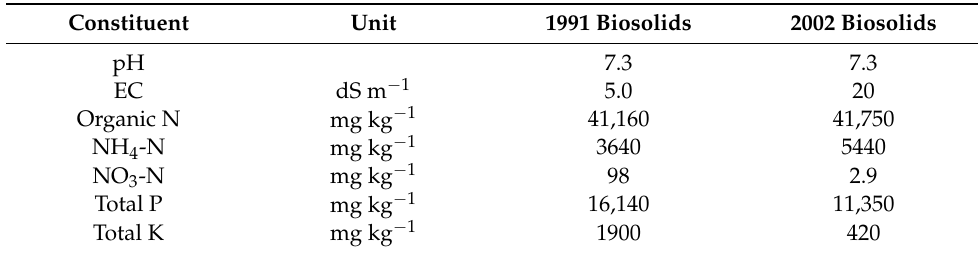
Table 1. Selected biosolids characteristics applied to the Meadow Springs Ranch shortgrass steppe rangeland site in 1991 or 2002 (adapted from Sullivan et al.